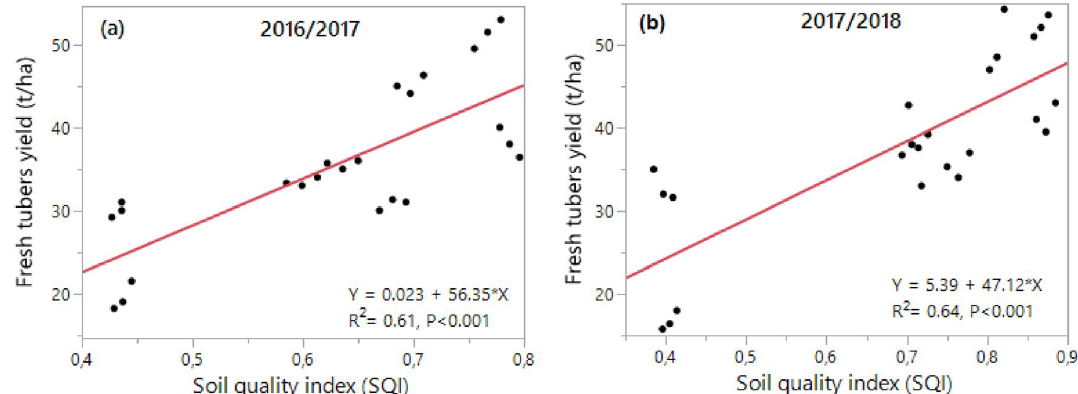
Figure 4. Relationships between Soil Quality Index (SQI) values and cassava yield in the 2016/2017 and 2017/2018 cropping seasons.